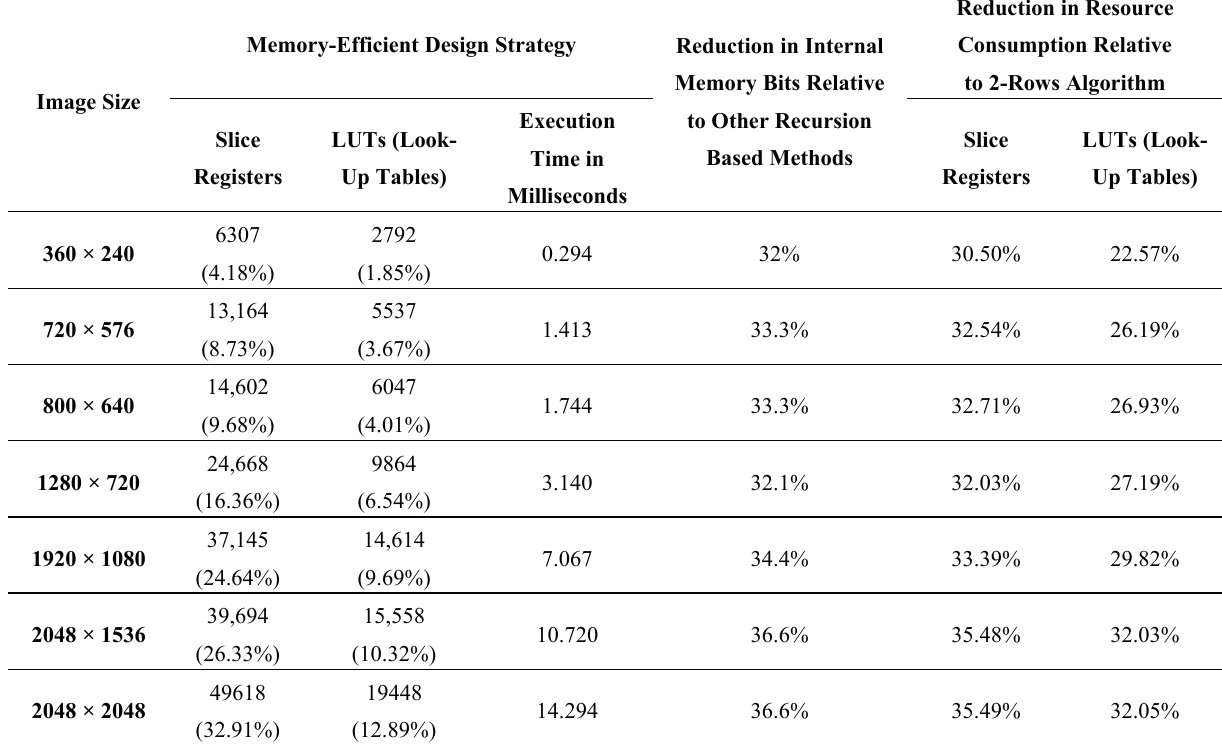
Figure 9. Block diagram of the proposed architecture. (cid:1861)((cid:1876), (cid:1877)) and (cid:1861)(cid:1861)((cid:1876), (cid:1877)) are the image pixel value and the integral image value at location ((cid:1876), (cid:1877)) in the image. (cid:1845)((cid:1876), (cid:1877)) is the row sum at that particular location. Table 3. Timing results and reduction in internal memory requirements for the proposed architecture on Virtex-6 XC6VLX240T. The values in parenthesis indicate the percentage of resources utilized for